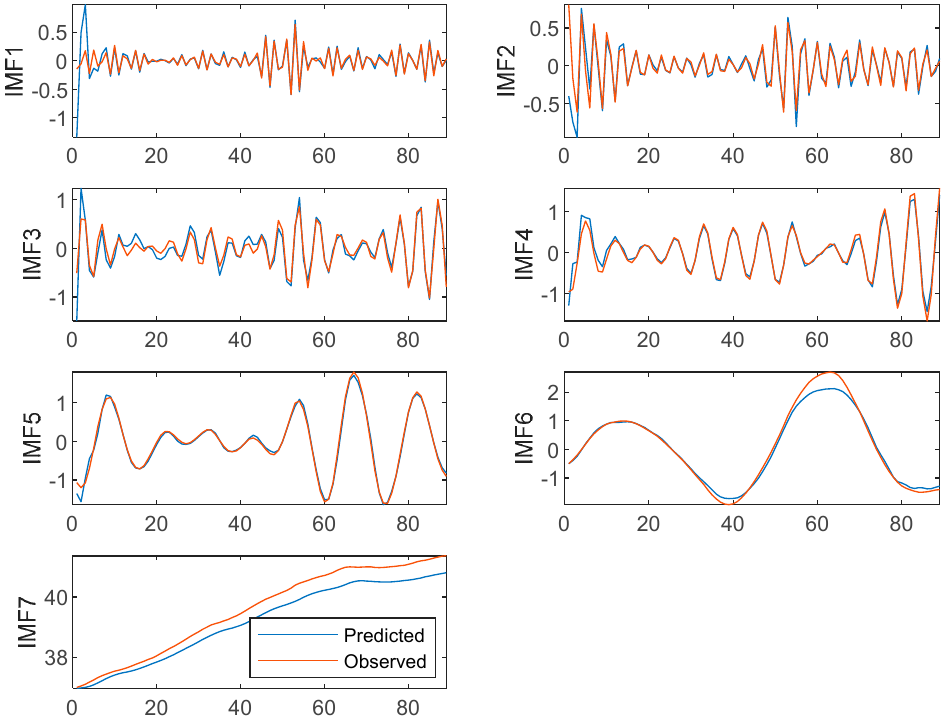
Figure 10. Fitting results for each IMF component of the big scallop price dataset. After summarizing each IMF, the regression images of each dataset are as follows (Figure 11):